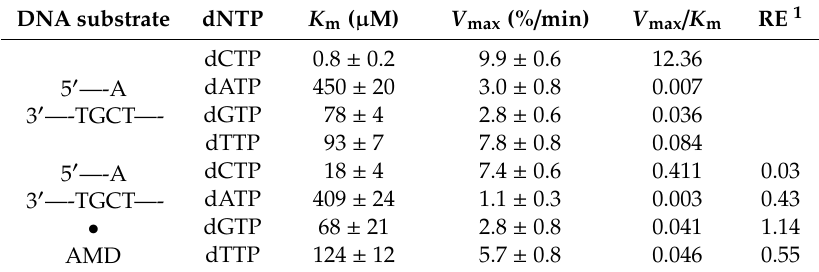
Table 2. Kinetics of Incorporation by Pol η of dNTPs opposite the G Platinated by AMD. DNA substrate dNTP K m ( µ M) V max (% / min) V max / K